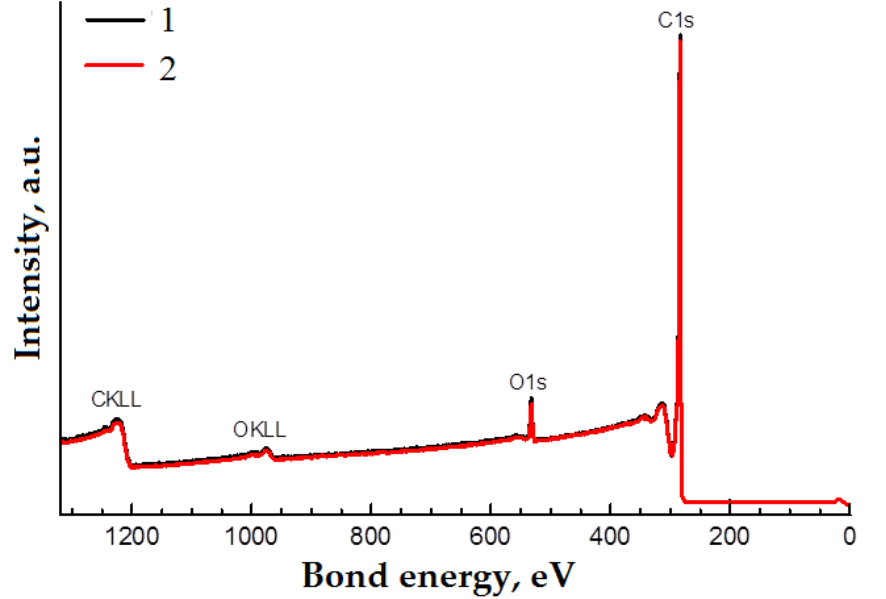
Figure 8. XPS spectra of initial CNTs (1) and CNTs after RESS (2).